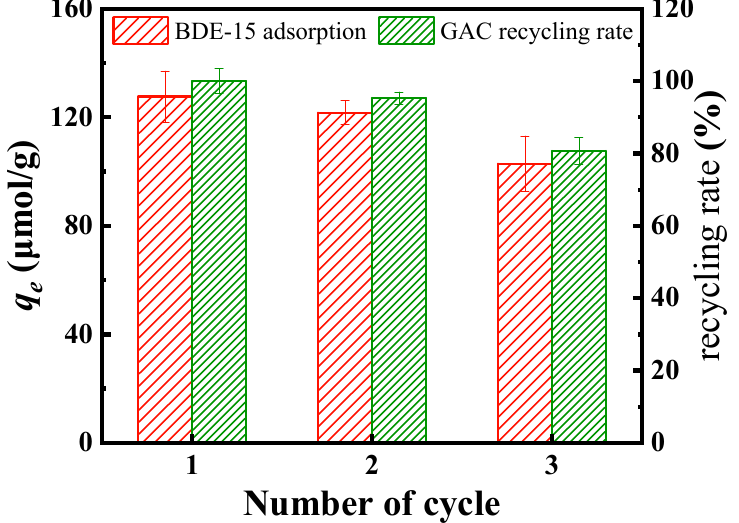
Figure 6. Reuse of GAC (Adsorption conditions: T = 298 K; C BDE-15 = 30 μ mol/L; C TX-100 = 1 g/L; pH = 6; Dosage = 0.1 g/L).